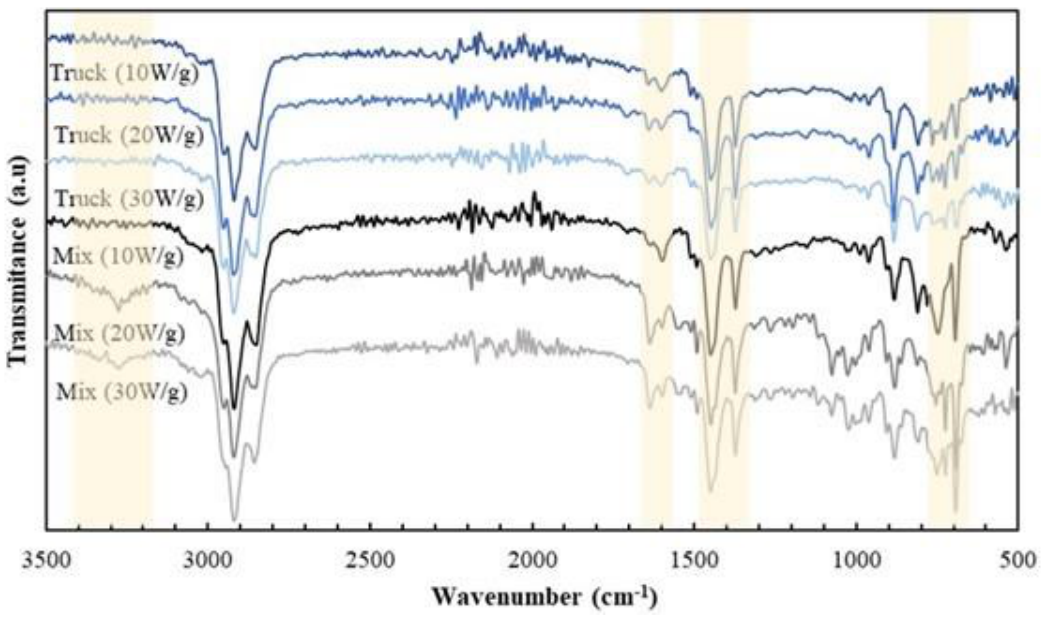
Figure 4. FTIR spectra (3500–500 cm −1 ) of the tire pyrolysis oils.